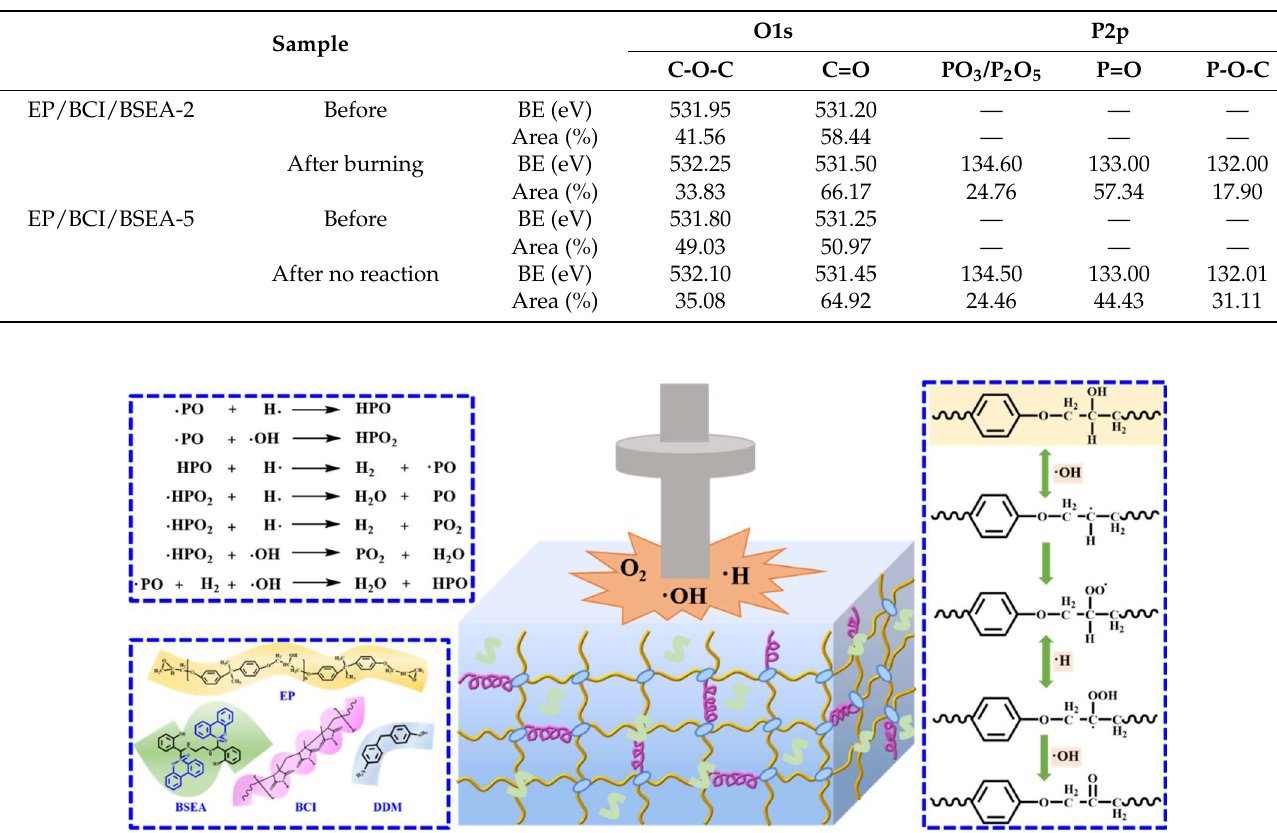
Table 4. O1s and P2p peak fitting results of pure EP and BSEA-modified EP.